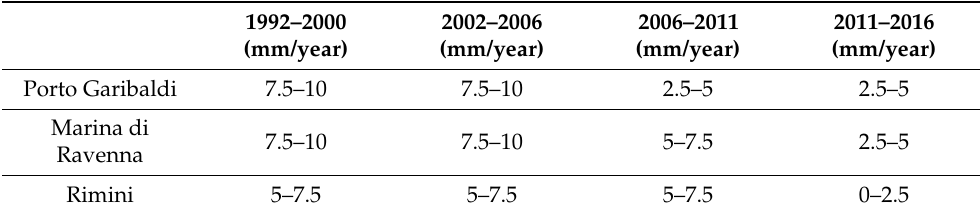
Table 4. Ranges for the rate of subsidence estimated over different time frames for each of the study sites from selected benchmarks of the E-R Coastal Geodetic Network